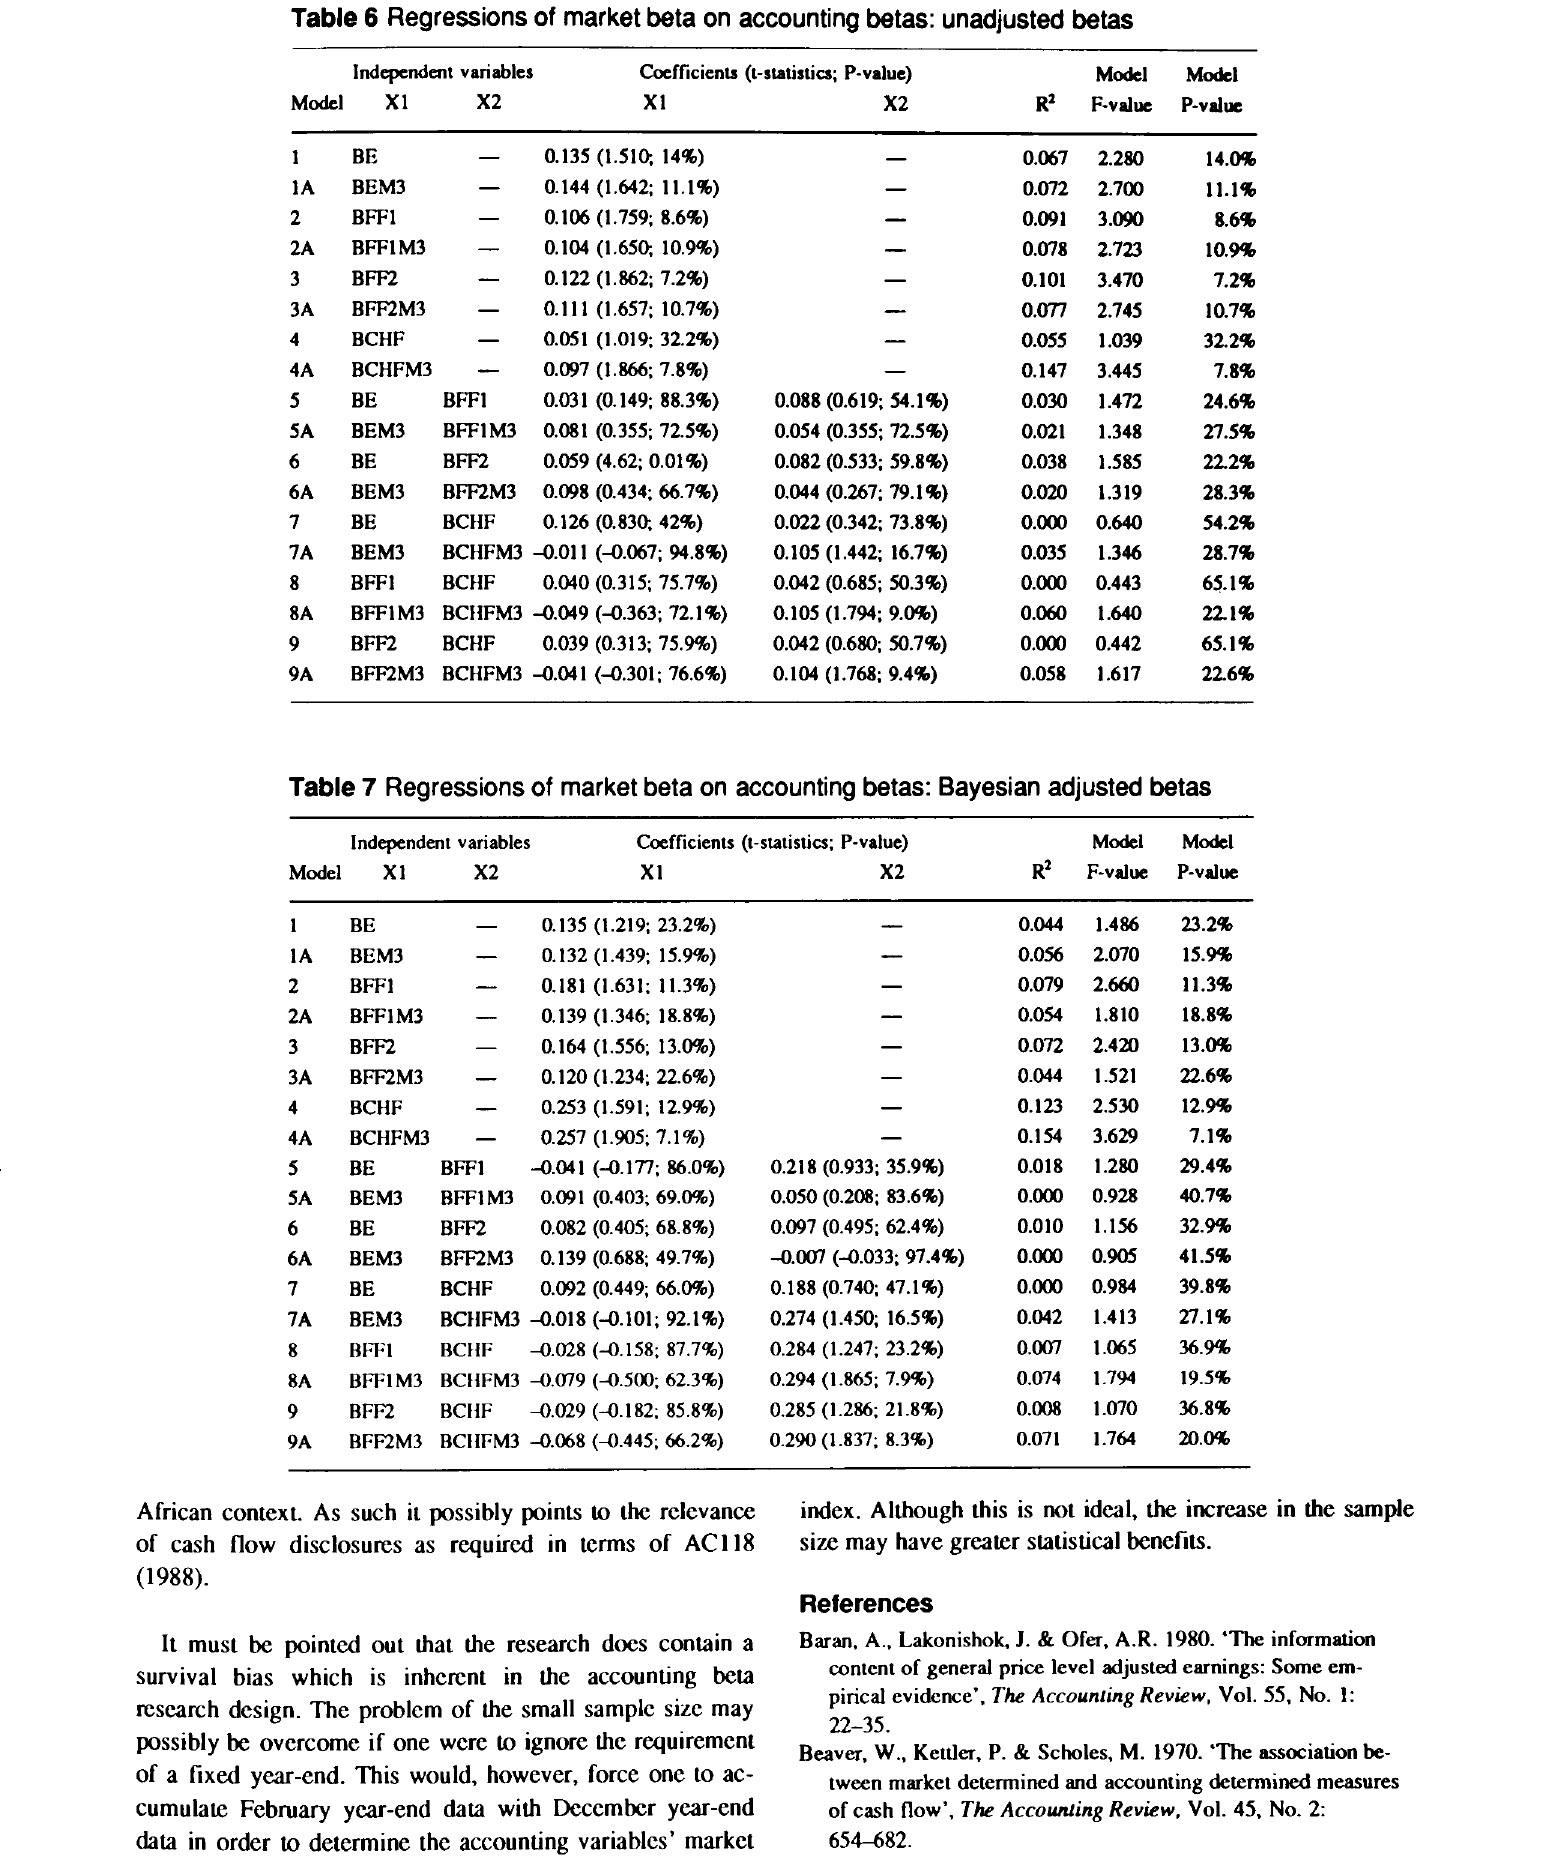
Table 6 Regressions of market beta on accounting betas: unadjusted betas